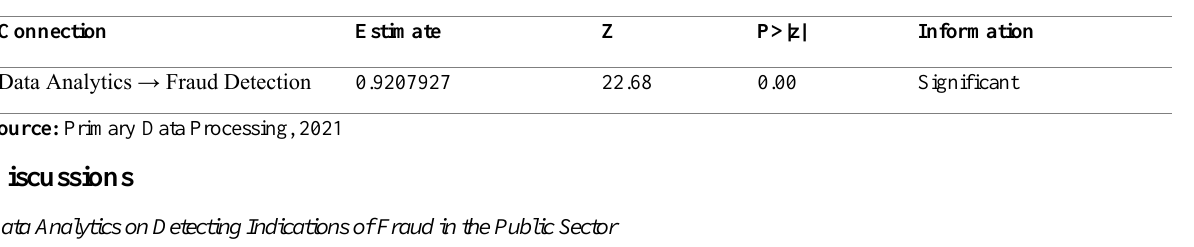
Table 6: Hypothesis